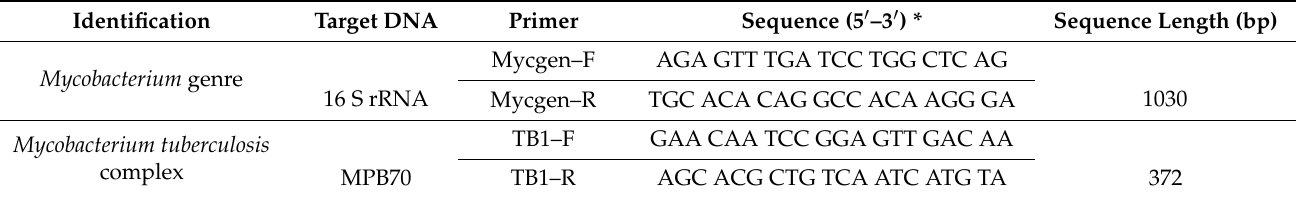
Table 1. Starter sequences were used in the reaction.